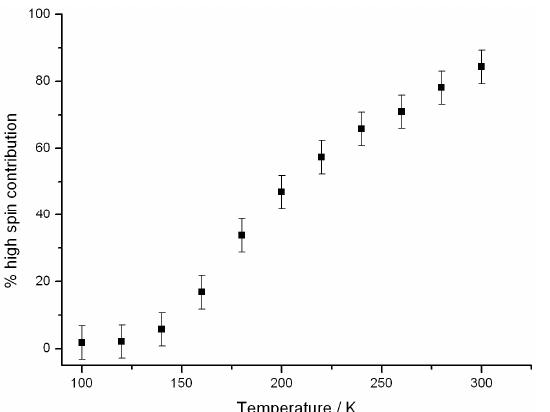
Figure 7. Graph derived from integral analysis of the Mössbauer data, showing temperature variation of the high-spin Fe(II) fraction in compound 2 . Table 2. Fitting parameters for variable temperature Mössbauer spectra 1 for compound 2 . Temperature/K Spin State δ Δ E Q